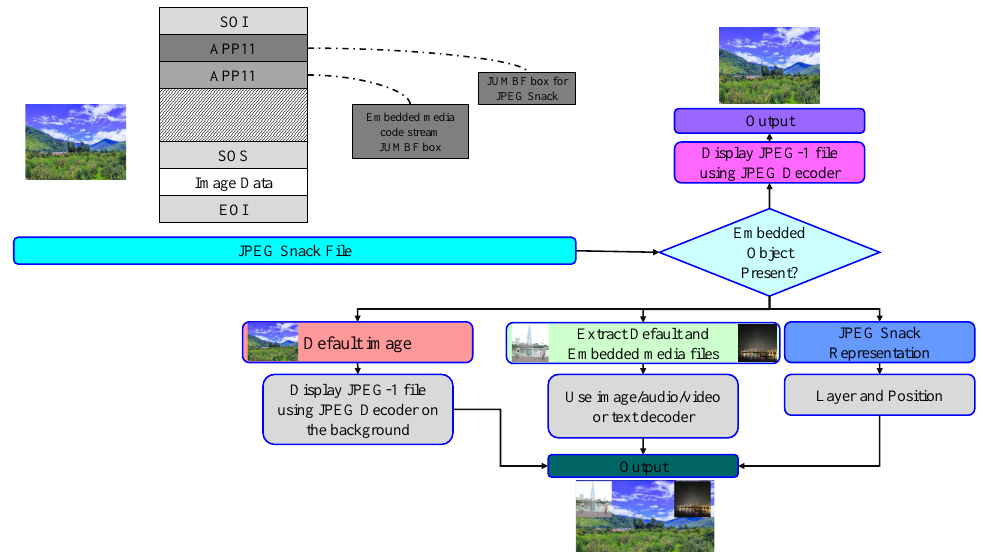
Figure 6. Visual representation of the steps involved in the JPEG Snack Player Algorithm.